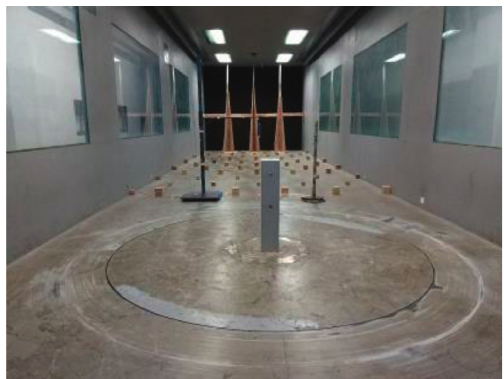
Figure 10: Model in the wind